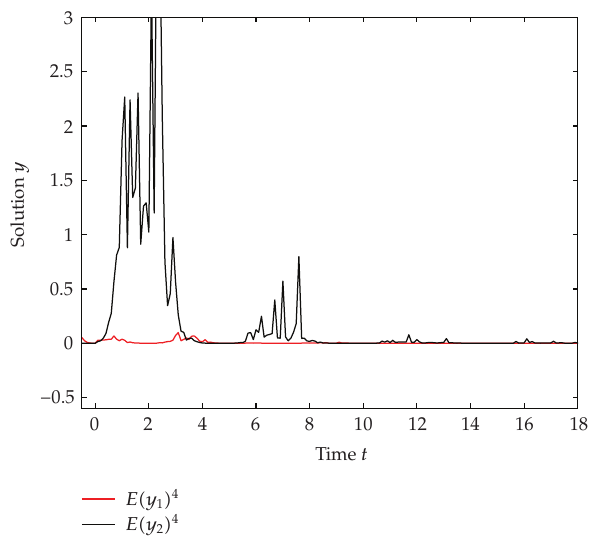
Figure 1: Numerical solution E (cid:5) y 4